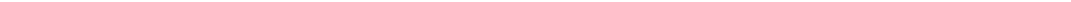
Fig. 1 A subpopulation of cholinergic interneurons, CGINs, expresses cholinergic and GABAergic markers. a ChAT (red) and Lhx6 (blue) co- immunolabeling in EGFP + (green) cells in Lhx6-iCre;RCE-EGFP mice. b Top: Representative images of biocytin- fi lled PLTS, FS, EGFP + , and EGFP − cholinergic interneurons (ChI) and (bottom) corresponding traces of their representative fi ring patterns. c RT-qPCR heat-map expression for ChAT, Lhx7, Lhx6, and GAD65 mRNAs in single cells (relative to HPRT mRNA; white to red: lowest to highest expression, SPN: negative control). d Representative reconstructed CIN and CGIN dendritic trees. e Sholl analysis of CGINs and CINs dendrites. f Distinct cluster formed by CGIN and CIN from PLTS and FS interneurons (3D plot of intrinsic properties). g Representative traces of cell-attached spontaneous spiking of CGIN, CIN, and PLTS interneuron. h Corresponding mean fi ring frequencies. i , j Top: Stimulation protocol; left: representative several superimposed consecutive i CGINs or j CINs responses to cortical train stimulation in cell-attached mode; right: responses within the train at extended time scale. Mean frequency histograms for k CGINs and l CINs. m Mean number of spikes during time windows after train stimulation (0 – 400ms, 800 – 1000ms) normalized to spikes counts before train. Scale bars: a 20 µ m; b , d 50 µ m. All means ± SEM. e Data sets were analyzed using Kolmogorov-Smirnov test; see Supplementary Table 1 for statistics. h , m Data sets were analyzed using one-way ANOVA followed by Fisher ’ s least signi fi cant difference (LSD) post-hoc test; see Supplementary Table 2 for statistics; * P < 0.05, *** P <